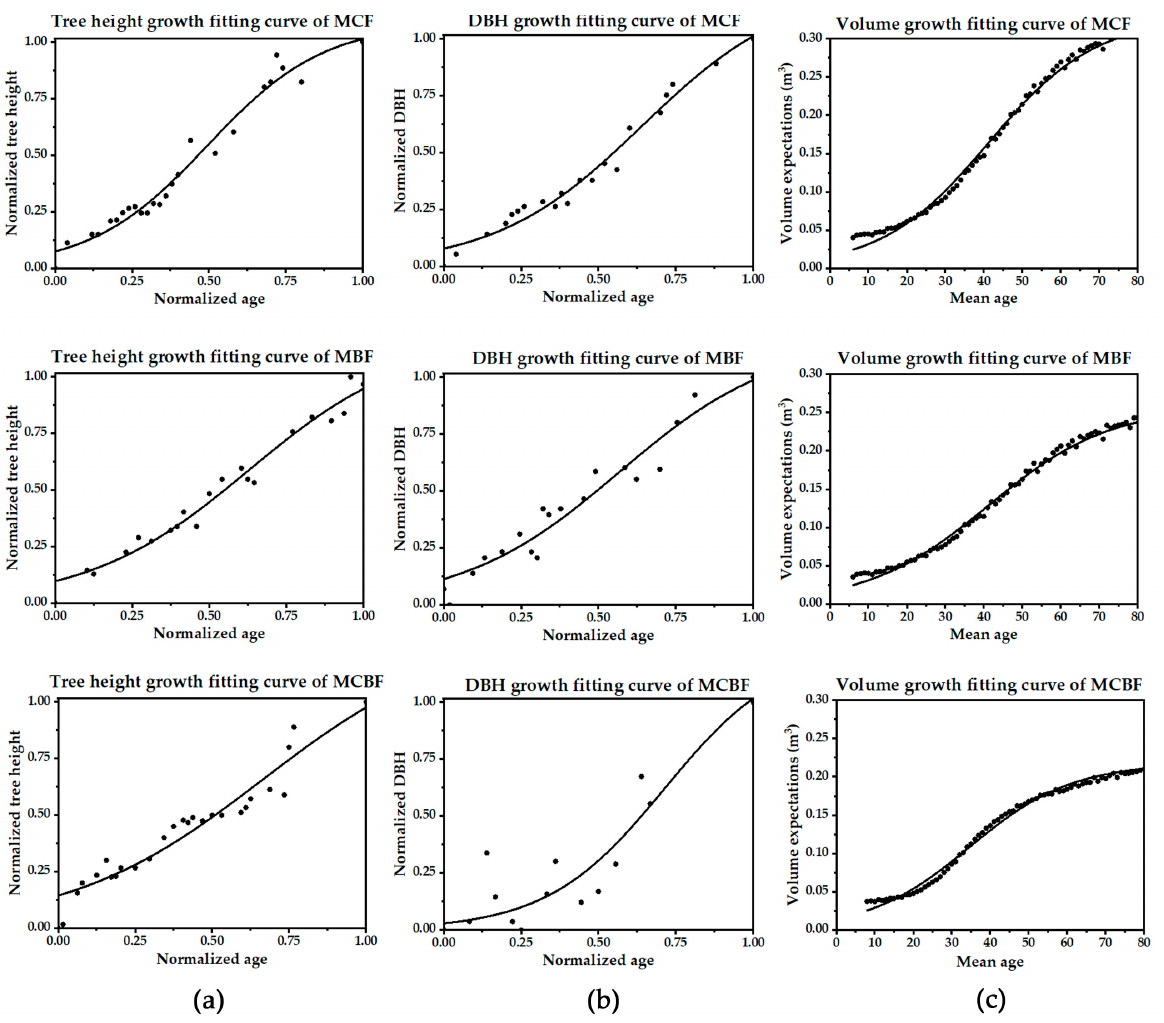
Figure A1. Variation curves of tree height, DBH, and volume expectation with age for different forest types. ( a ) shows the tree height-standardized age fitting relationship; ( b ) shows the DBH- standardized age fitting relationship; ( c ) shows the accumulation volume expectation-mean age fitting relationship after random simulation. PF refers to pine forest; CFF refers to Chinese fir forest; BLH refers to hard broad forest; BLS refers to soft broad forest; and three types of mixed forests: MCF refers to mixed coniferous forest, MBF refers to mixed broadleaf forests, and MCBF refers to mixed conifer-broadleaf forests. (The points in the graph represent forest patches sampling data.).